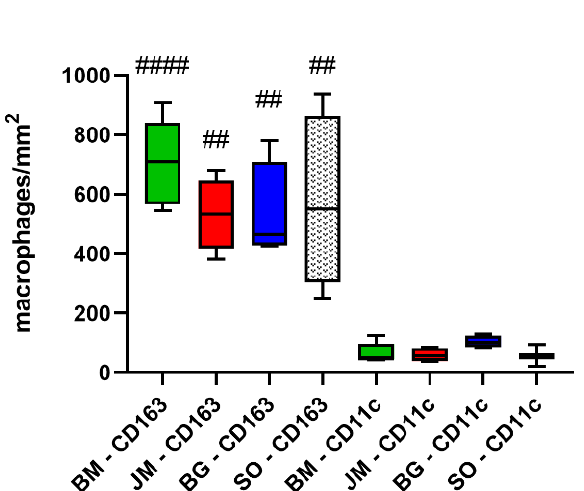
Figure 12. Results of the histomorphometrical measurements of the macrophage distribution at day 90 post implantationem (# = interindividual differences; ##: p < 0.01 and #### p < 0.0001). BM: bovine membrane, JM: Jason ® membrane, BG: Bio-Gide ® , SO: sham operation.